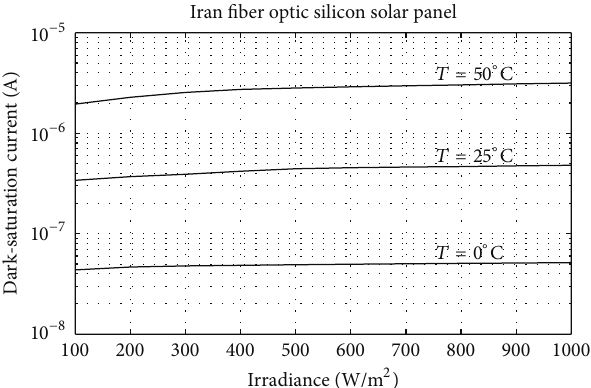
Figure 5: Dark-current saturation of the solar panel under investi- gation.